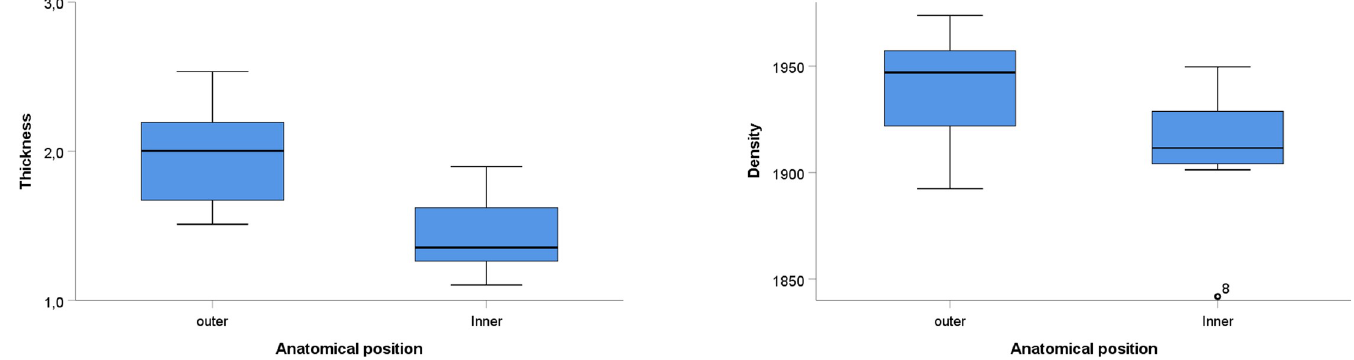
Fig 3. Differences in thickness (mm), and densities (kg/m 3 ) between inner and outer cortical cranial plates.